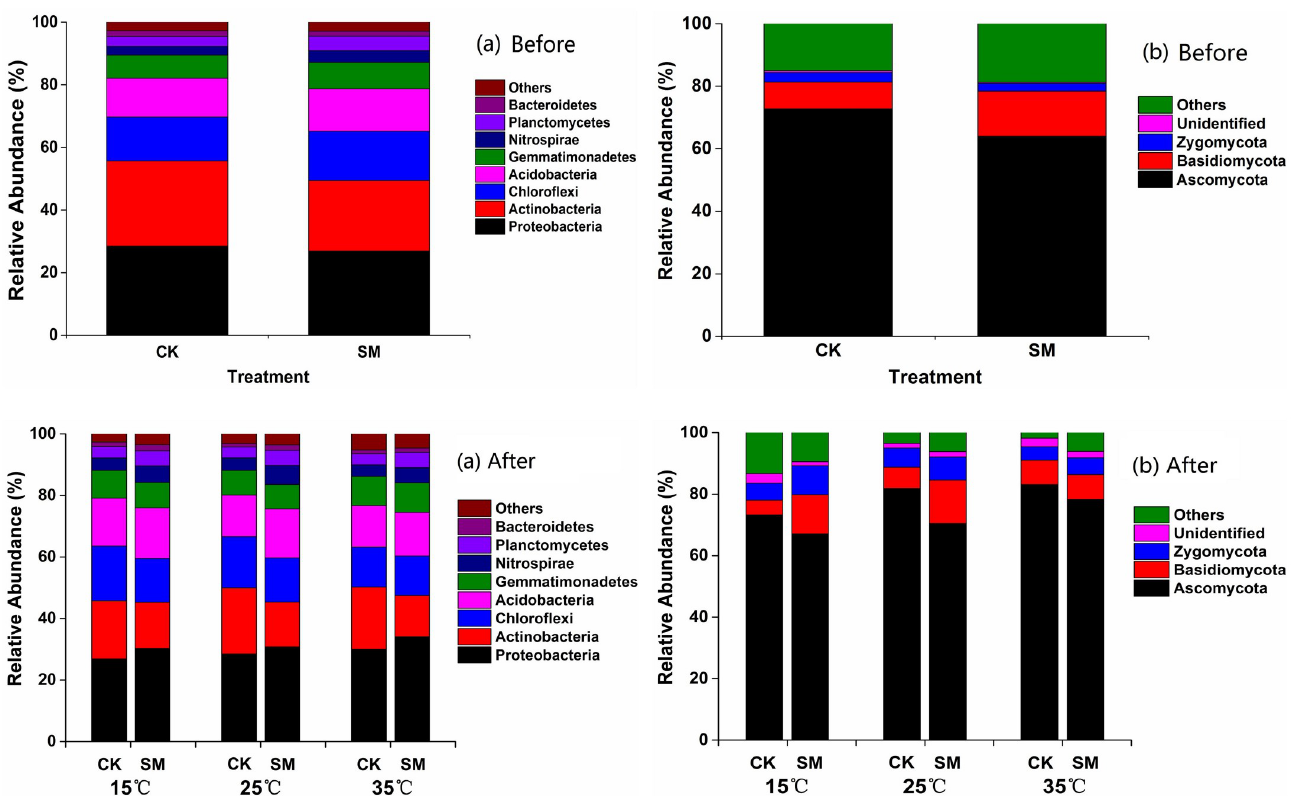
Fig 6. Relative abundances of (a) bacterial and (b) fungal phyla under straw mulching and no mulching before and after incubation. CK: no mulching; SM: straw mulching.